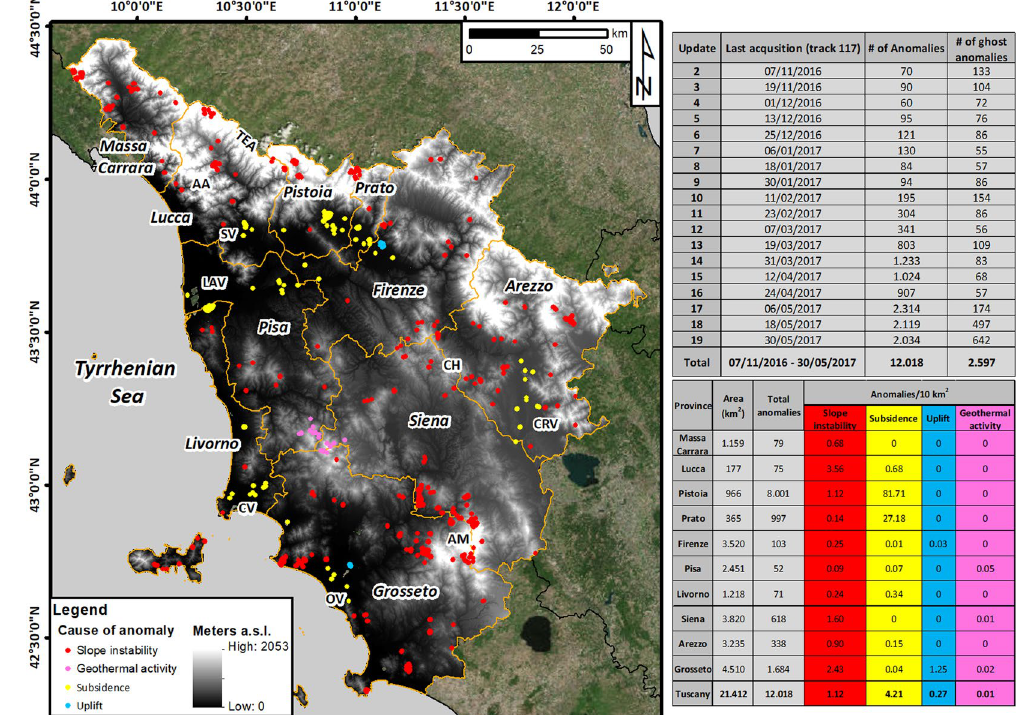
Figure 2. TS anomalies classified according to the driving force as at Update #19. Anomalies related to slope instabilities are widespread in most of the mountain areas of the region. Anomalies related to subsidence phenomena are identified in the alluvial plains, along with two uplifting areas within the province of Grosseto and Firenze. Anomalies linked to geothermal activities straddle the provinces of Pisa, Siena and Grosseto. TEA (Tuscan-Emilian Apennines); AA (Apuan Alps); SV (Serchio Valley); LAV (Lower Arno Valley); CH (Chianti Hills); CRV (Chiana River valley); AM (Amiata Mountain); CV (Cornia Valley); OV (Ombrone Valley). Maps were generated using ESRI ArcGIS 10.3 platform